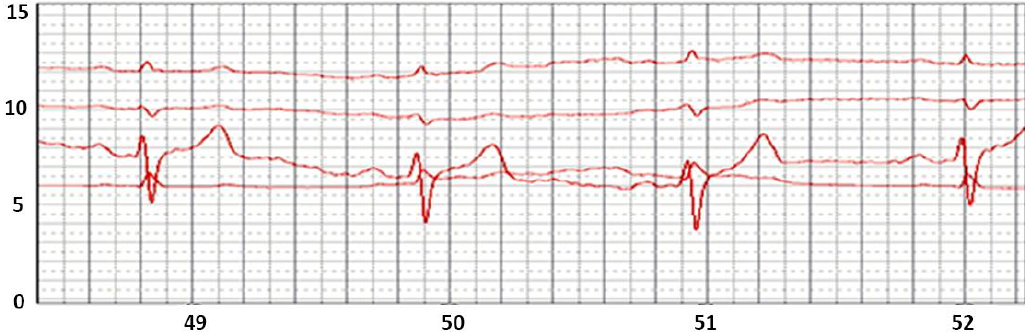
Figure 4. ECG from chest non-standard ECG leads recorded through clothing.